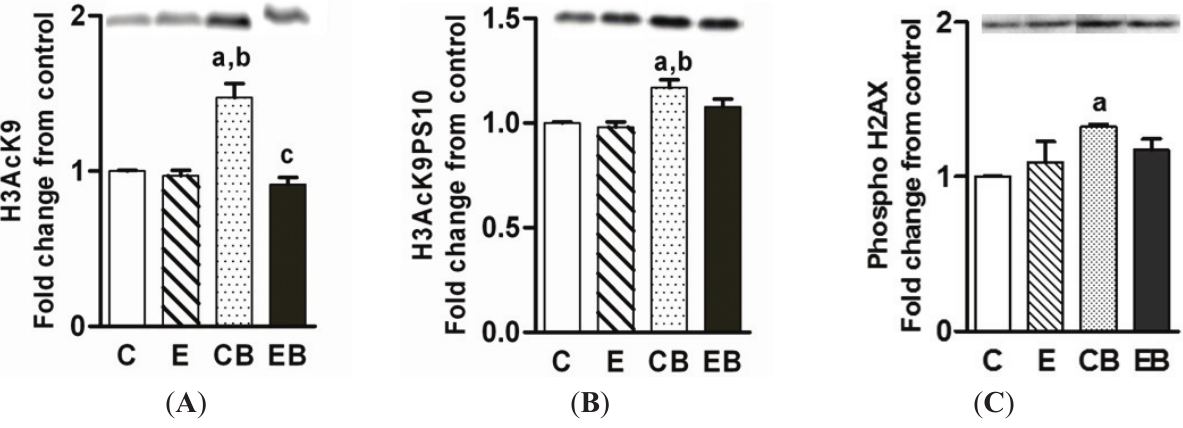
Figure 5. Levels of H3AcK9 ( A ); H3AcK9PS10 ( B ); and phospho-H2AX ( C ). The